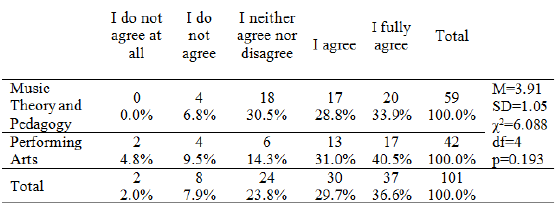
Table 6. Students’ attitude on fighting religious prejudice, by study program